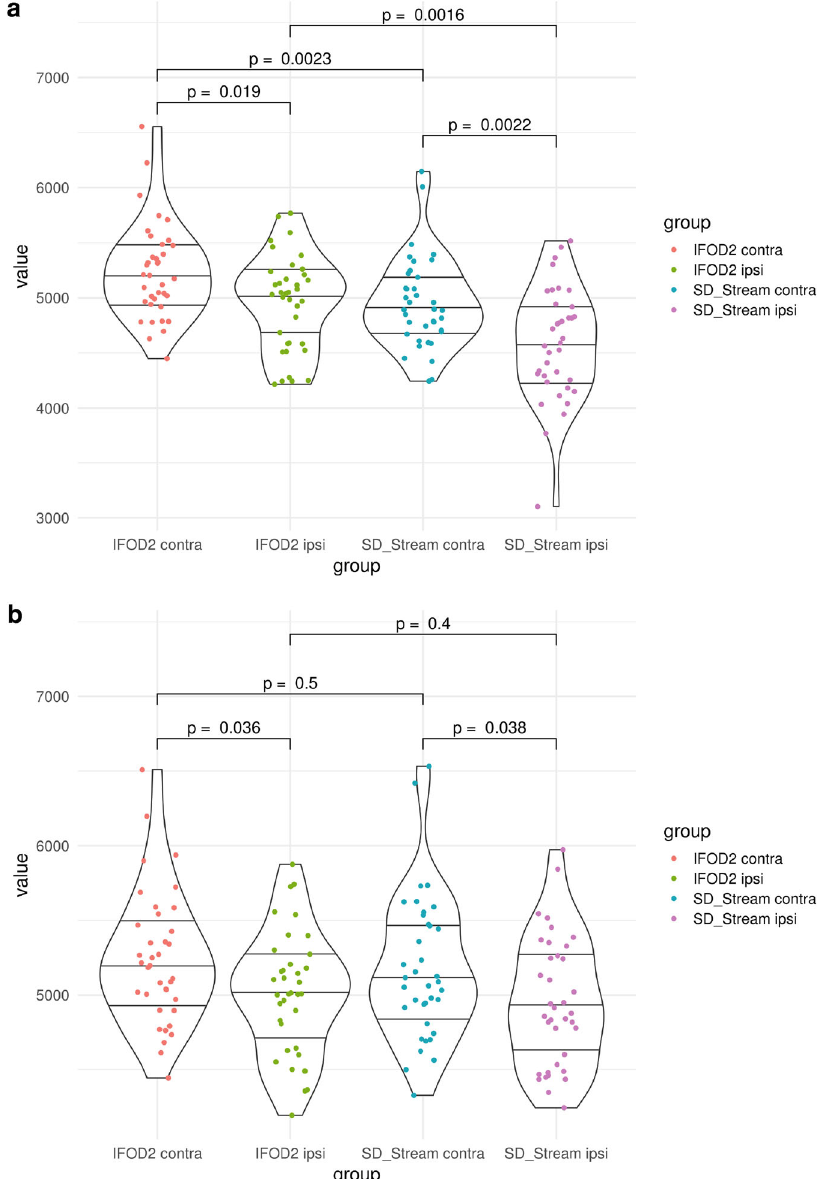
Fig. 4 Wilcoxon tests for ef fi ciency measures. Violin plots of Wilcoxon tests for global ( a ) and local ef fi ciency ( b ) by testing the differences of ipsilesional (*_ipsi) and contralesional (*_contra) hemispheres in relation to the tractography